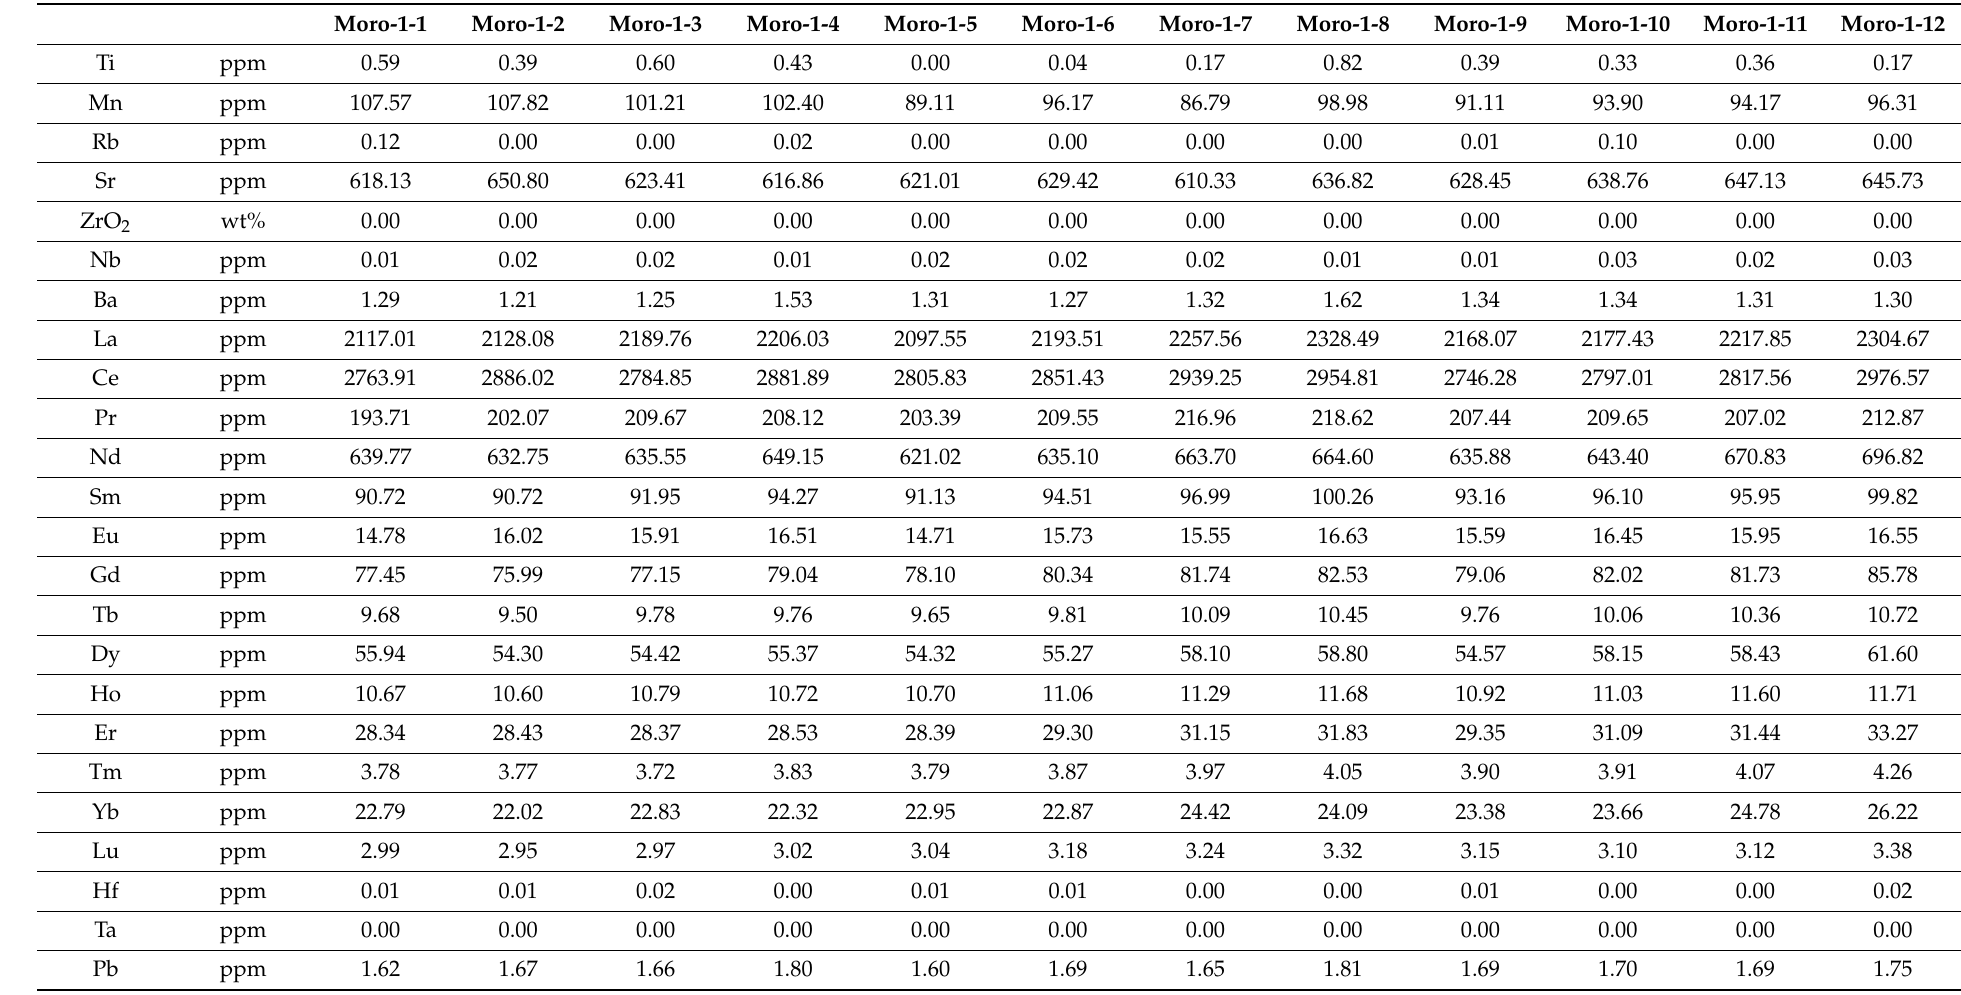
Table 3. Chemical composition and structural formula of Moroccan apatite, analysed by